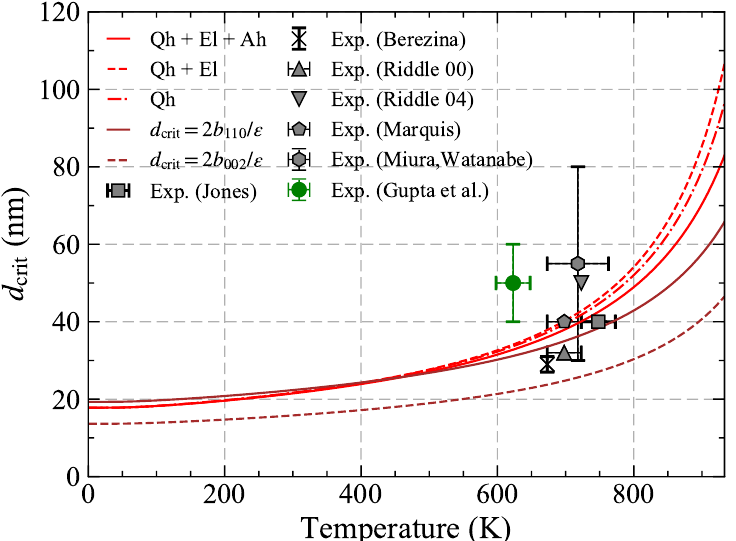
Figure 7. Variation of critical particle diameter of Al 3 Sc particles with temperature. The red dashed-dotted/dashed/solid lines correspond to the calculated values as per Equation (10) including quasiharmonic (Qh), additional electronic (Qh+El), and additional anharmonic (Qh+El+Ah) contribu- tions to ε ( T ) and (cid:126) b ( T ) . The symbols hexagons [98,102], up-triangles [103], square [104], crosses [105], down-triangles [106], pentagons [16] represent average experimental values for the coherency loss, whereas the variation in terms of temperature and size is given by error bars. The green symbol corresponds to our recent measurements [101]. The solid and dashed brown lines correspond to the calculation of critical diameters within a pure geometric consideration for two choices of the Burgers vector. The figure has been taken from